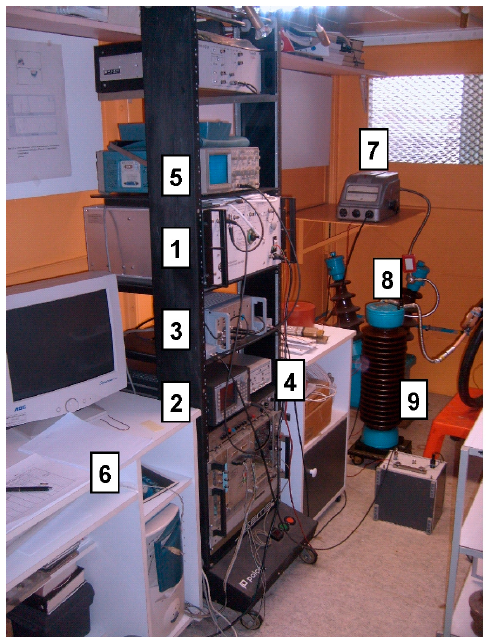
Figure 20. Laboratory equipment and instruments used for PD measurements: (1) solid-state high- voltage amplifier TREK 20/20B (HVA); (2) arbitrary waveform generator Analogic 2030 (AWG); (3) PD data acquisition system ICMsystem (PDA) with pre-amplifier (SCU); (4) programmable amplifier SR560; (5) digital storage oscilloscope; (6) computer with IEEE.488 interface and control software; (7) electrostatic kilovoltmeter; (8) coupling capacitor C k ; (9) measuring impedance Z m .